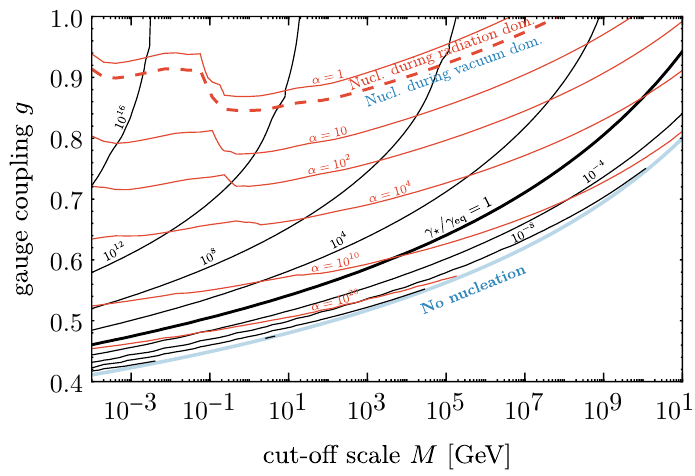
Figure 10 . Contours of α as well as the bubble wall boost factor γ ? normalized to the equilibrium value γ eq from eq. (B.12). Note that α is evaluated at the percolation temperature T p , whereas the nucleation line between vacuum and radiation domination (red, thick-dashed line) depends on the nucleation temperature.